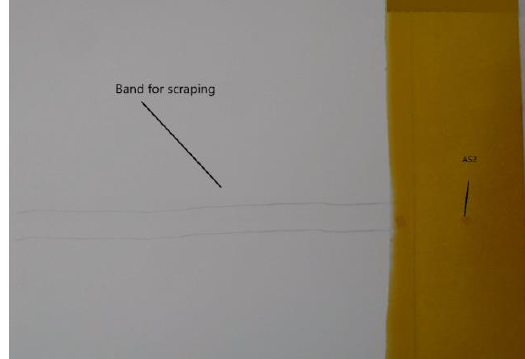
Figure 3. preparative TLC for isolated AS2 from chloroform fraction after basify with developed the A2 solvent system with Dragendorff reagent.